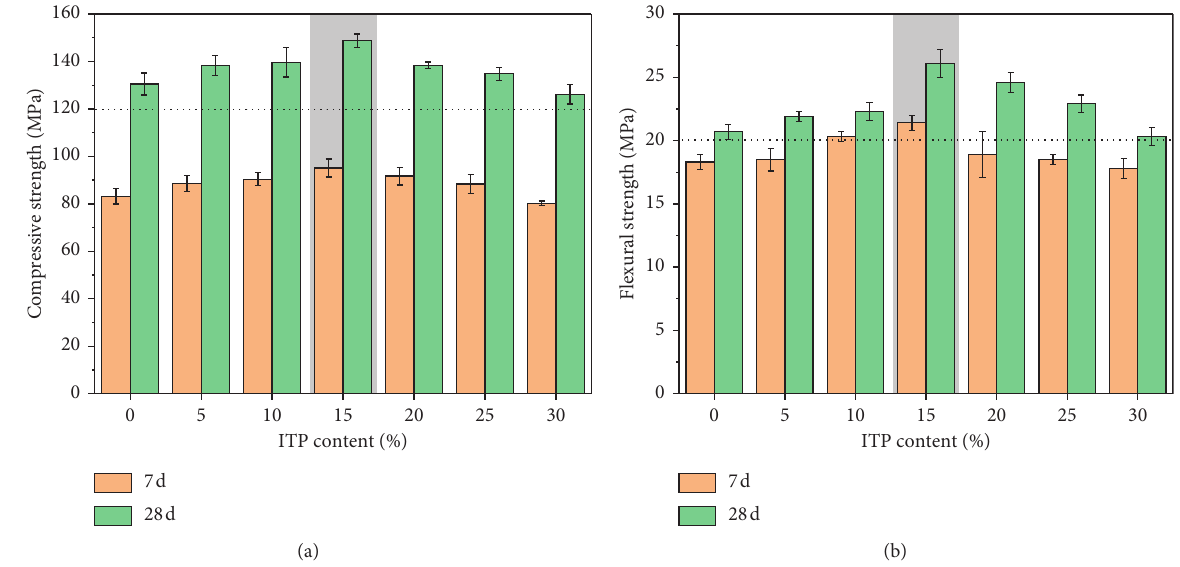
Figure 2: Mechanical properties of UHPC mortar: (a) compressive and (b) flexural strength.